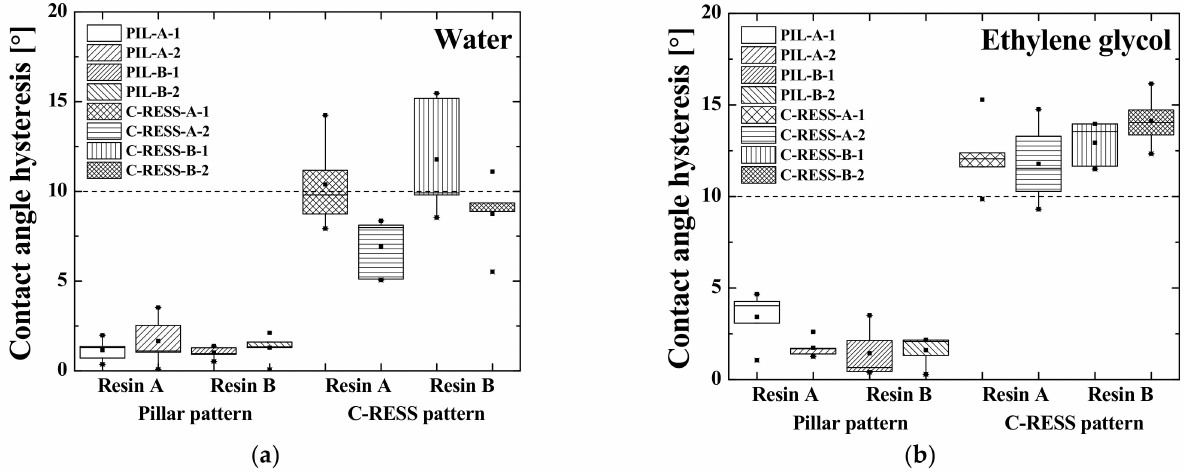
Figure 18. Effects of micro-structure pattern and resin type on the contact angle hysteresis (CAH) of ( a ) water droplets and ( b ) ethylene glycol droplets dispensed on the imprinted